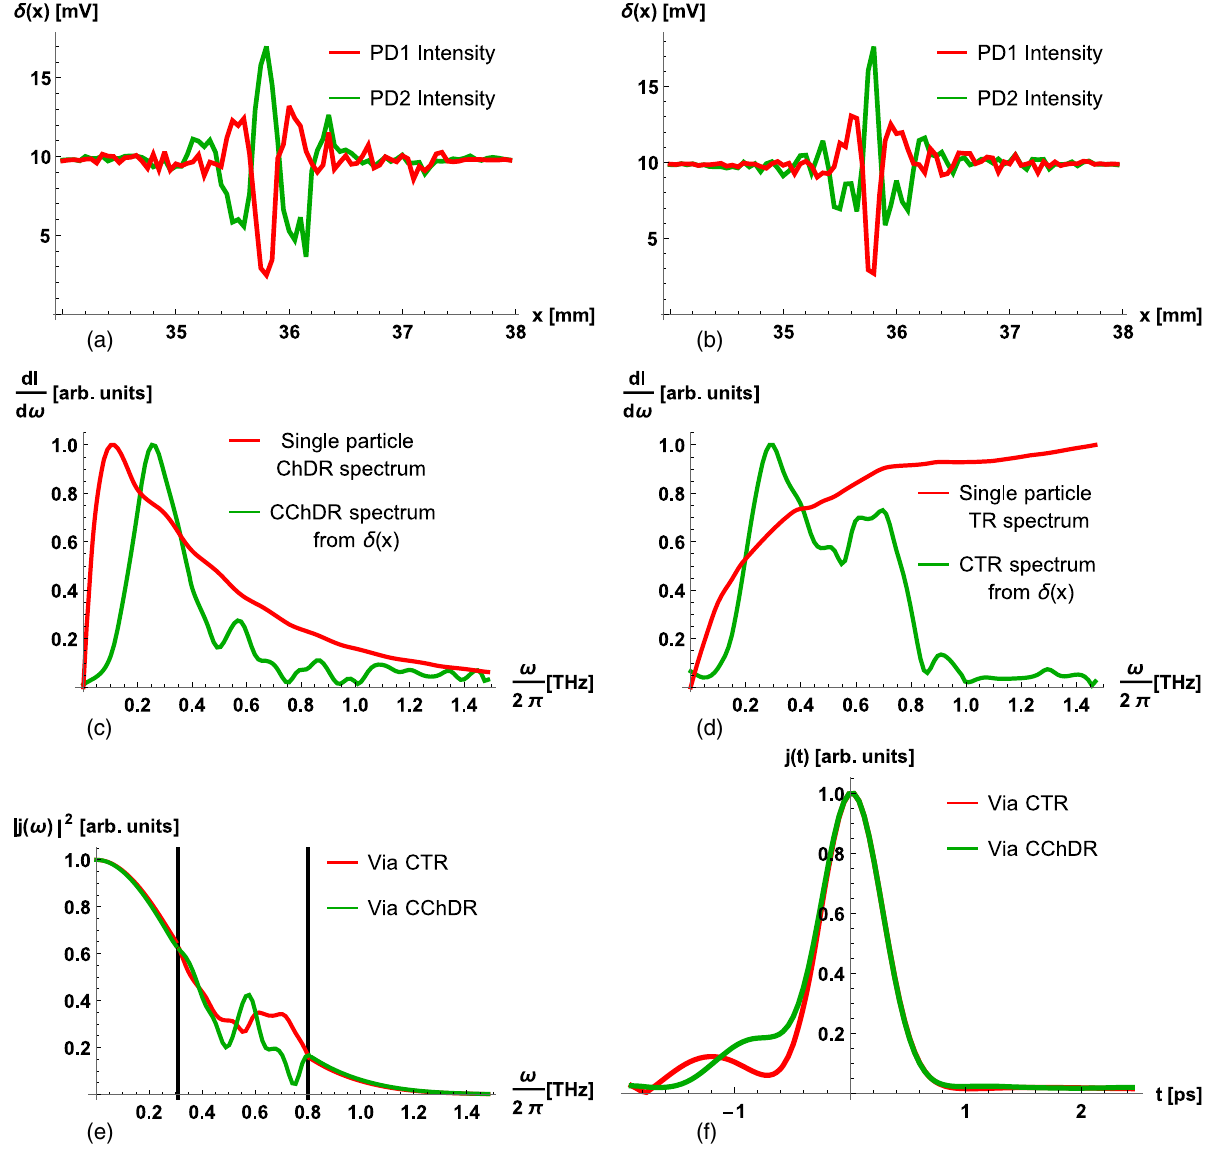
FIG. 12. Interferograms of the CChDR (a) and CTR (b) measured by two detectors; single electron (red) and spectra of CChDR (c) and CTR (d) derived from the corresponding interferograms; (e) extrapolated bunch form factor via both CChDR and CTR; (f) bunch profile reconstruction via CChDR and CTR given the same rf settings in the